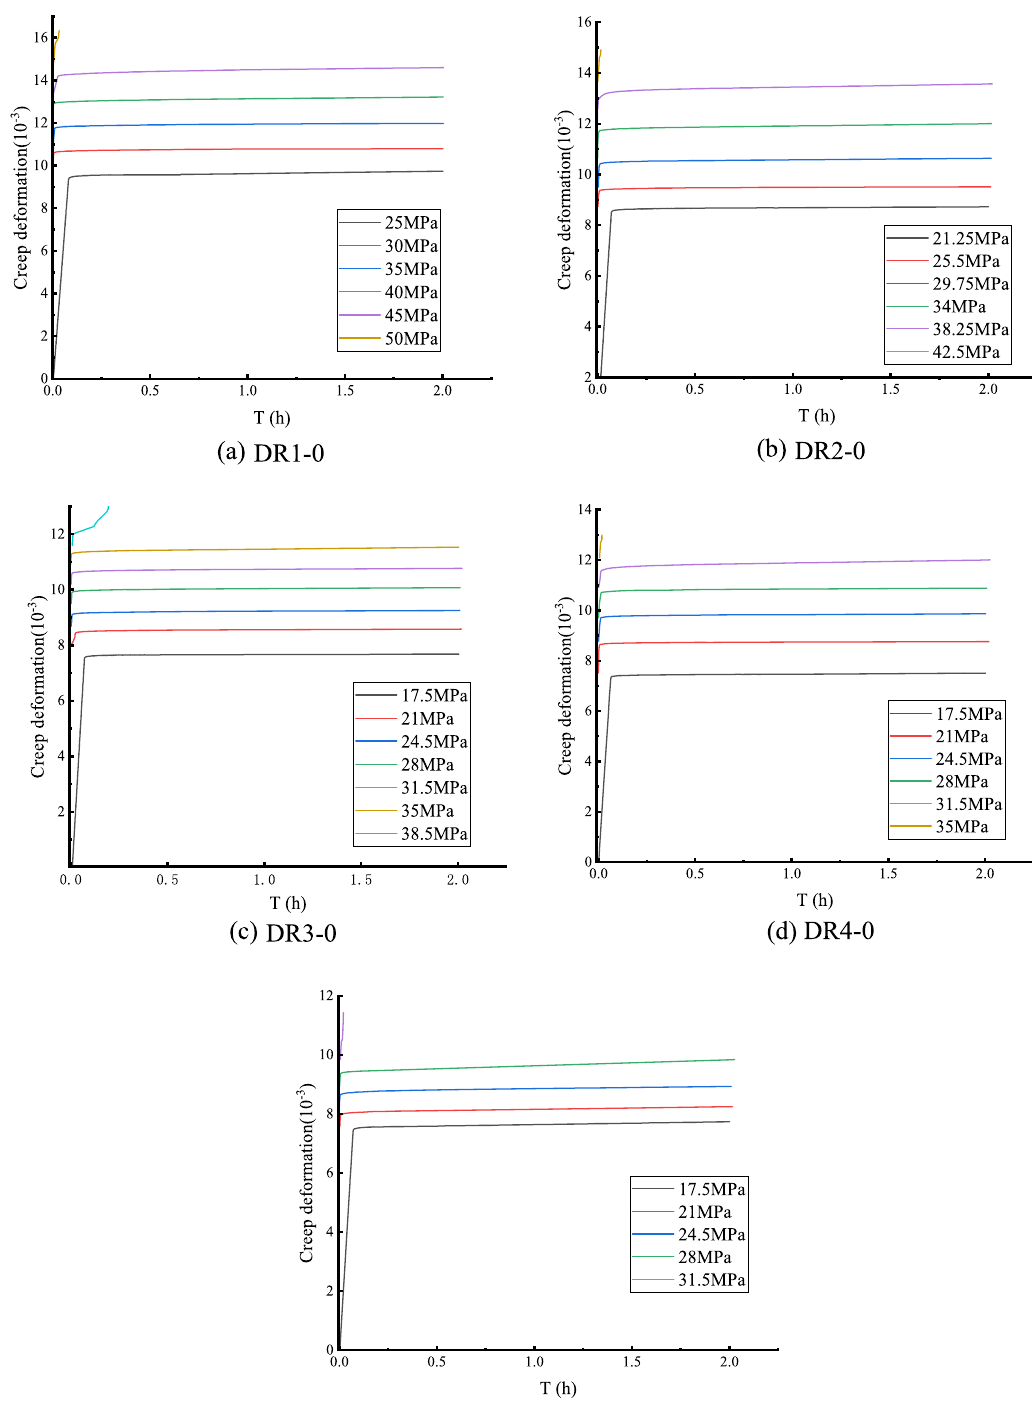
Figure 8. Creep curve of white sandstone with pre-peak unloading